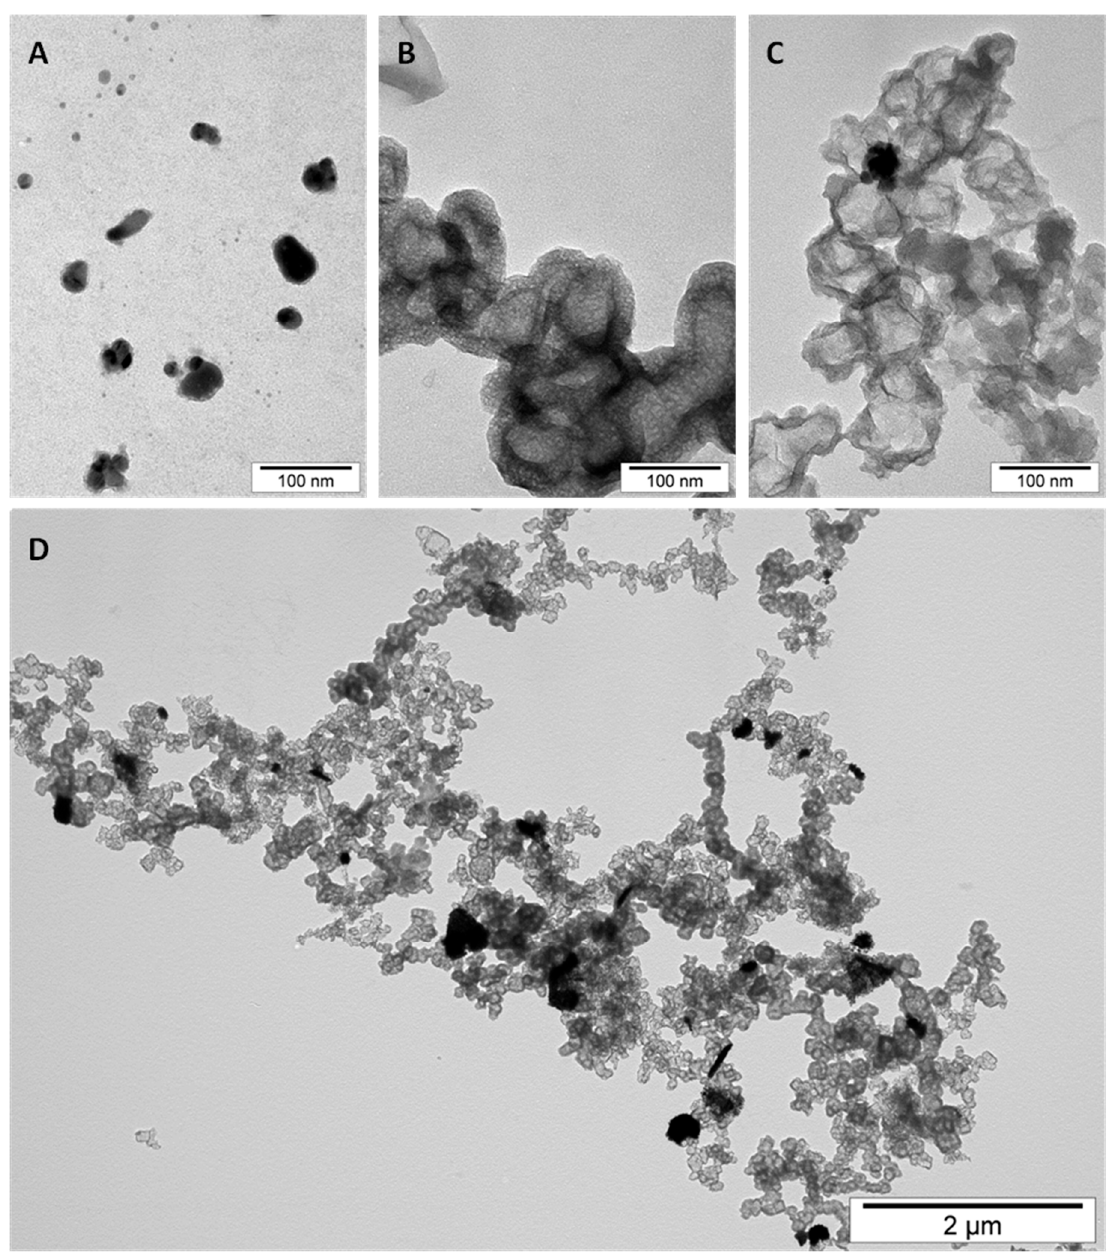
Figure 1. Morphology and structure of nanomaterials and their mixture: ( A ) silver nanoparticles; ( B ) carbon nanostructures (hierarchical nanoporous graphenic carbon (HNC)); ( C , D ) the mixture of silver nanoparticles and carbon nanostructure.